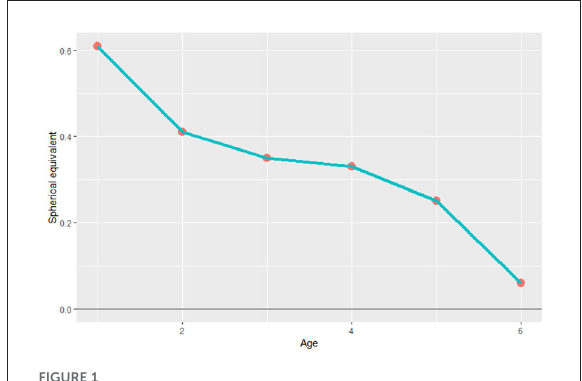
FIGURE1 The mean SE among the different age groups. SE, spherical